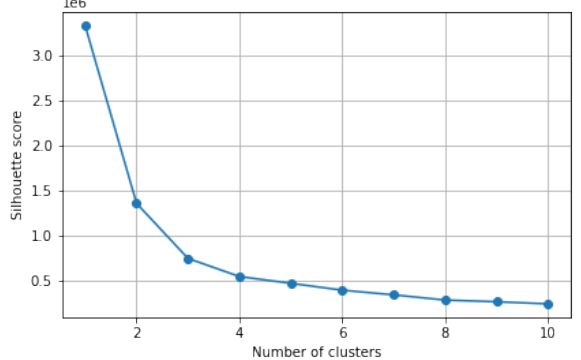
Figure 7. Silhouette score for different number of clusters ( k